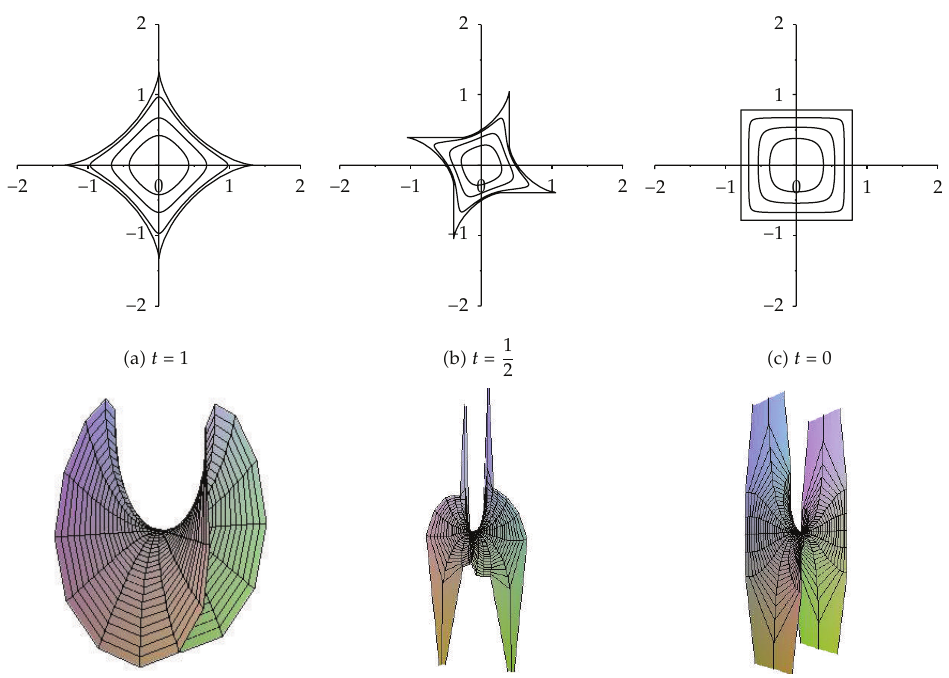
Figure 2: Images of concentric circles under f and corresponding minimal surfaces for various values of t in Example